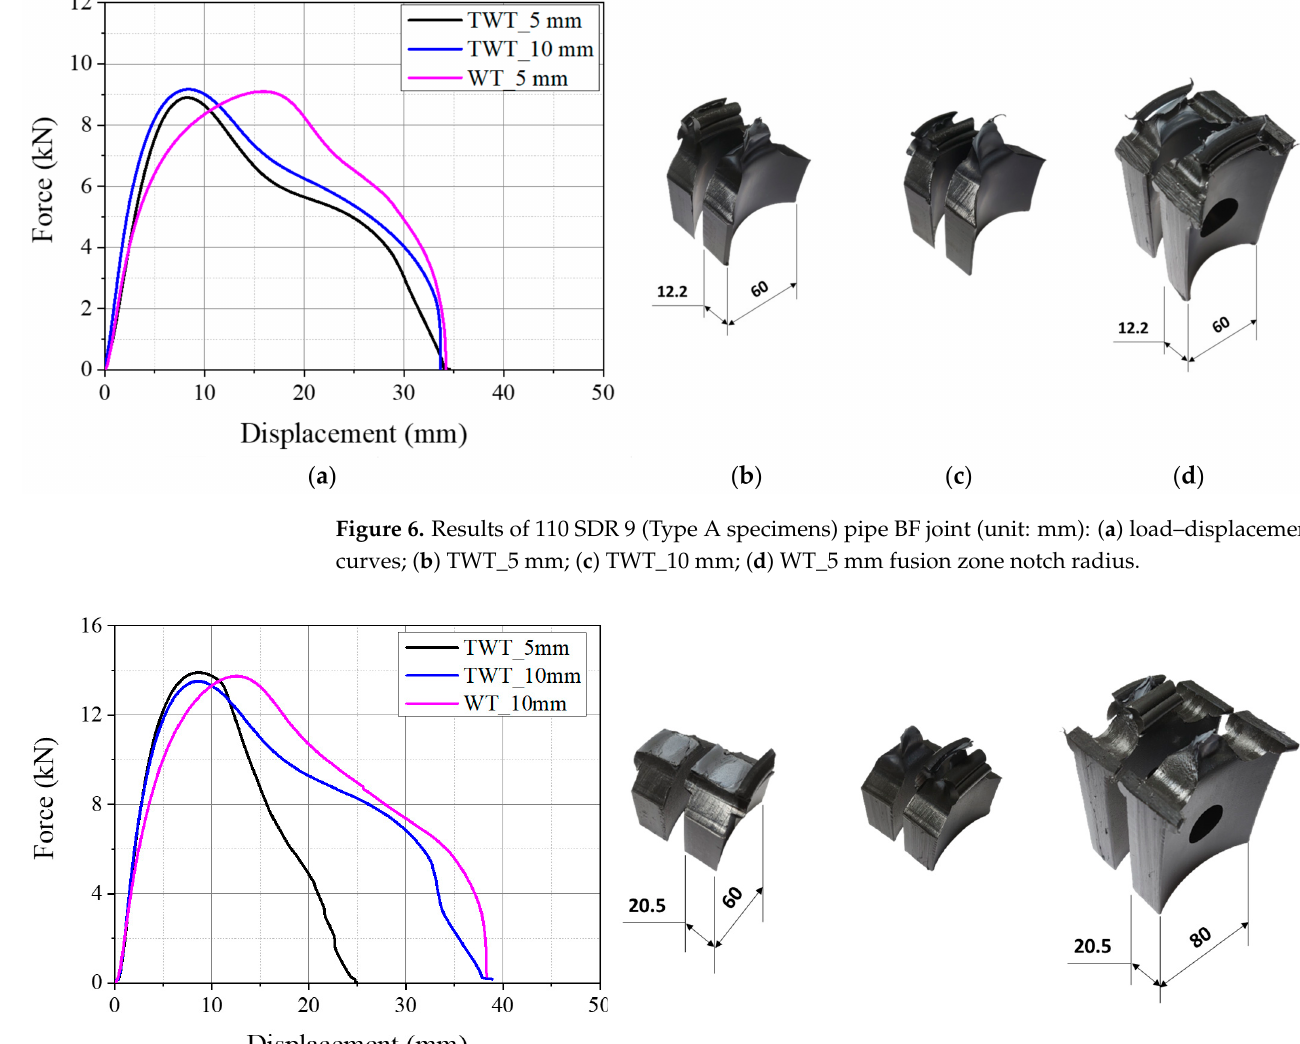
Table 4. Maximum load and corresponding displacement of Type A, 110 SDR 9 TWT, and WT spec- imens.